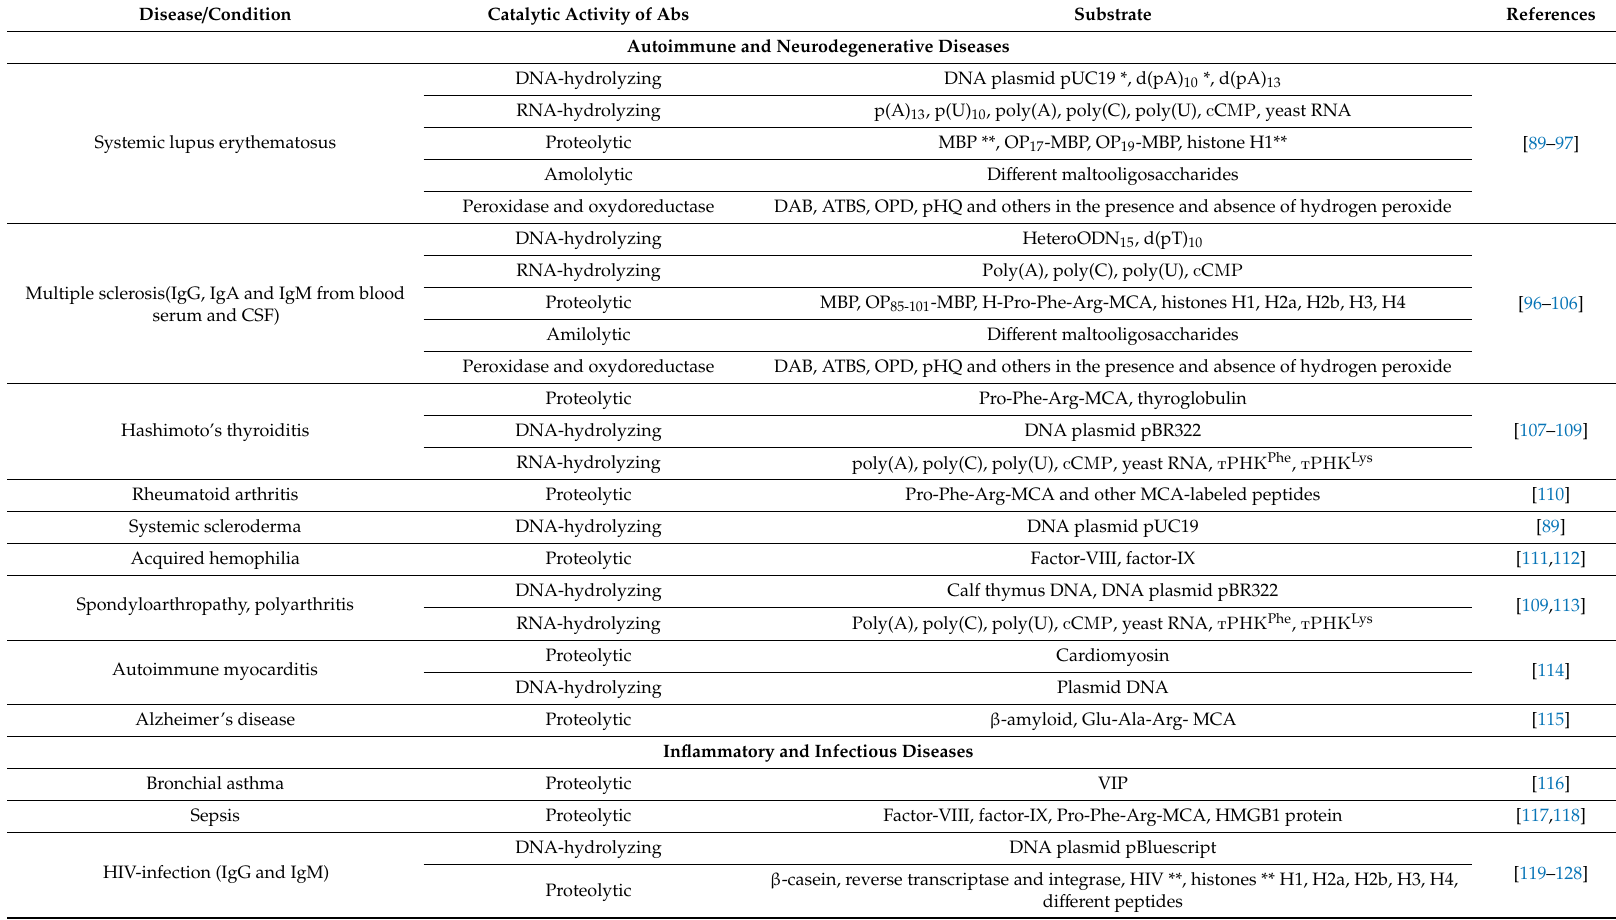
Table 3. Comparison of the origin and features of various Ab types in